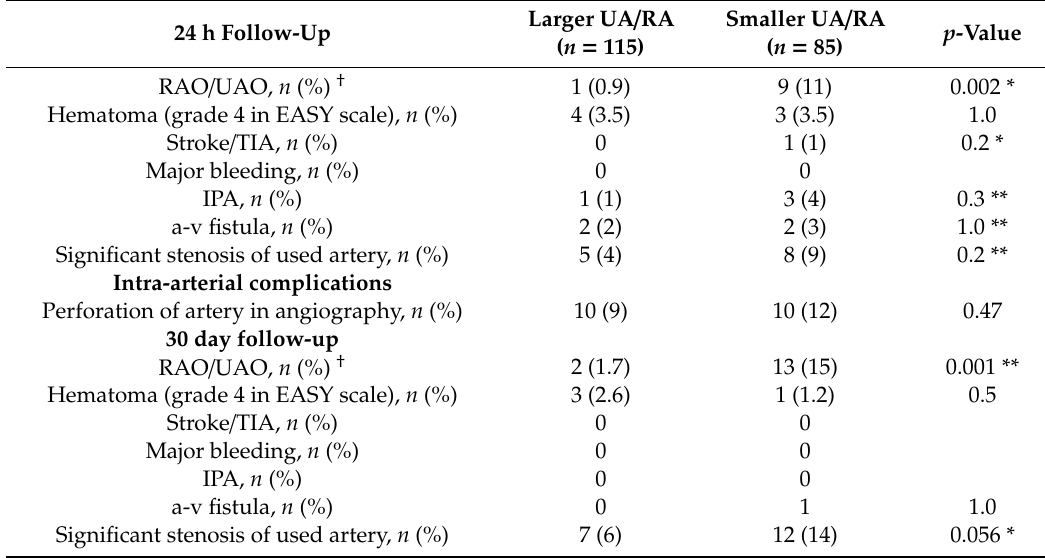
Table 6. Number (%) of patients with secondary endpoints and complications after CAG / PCI at 24 h and 30 day